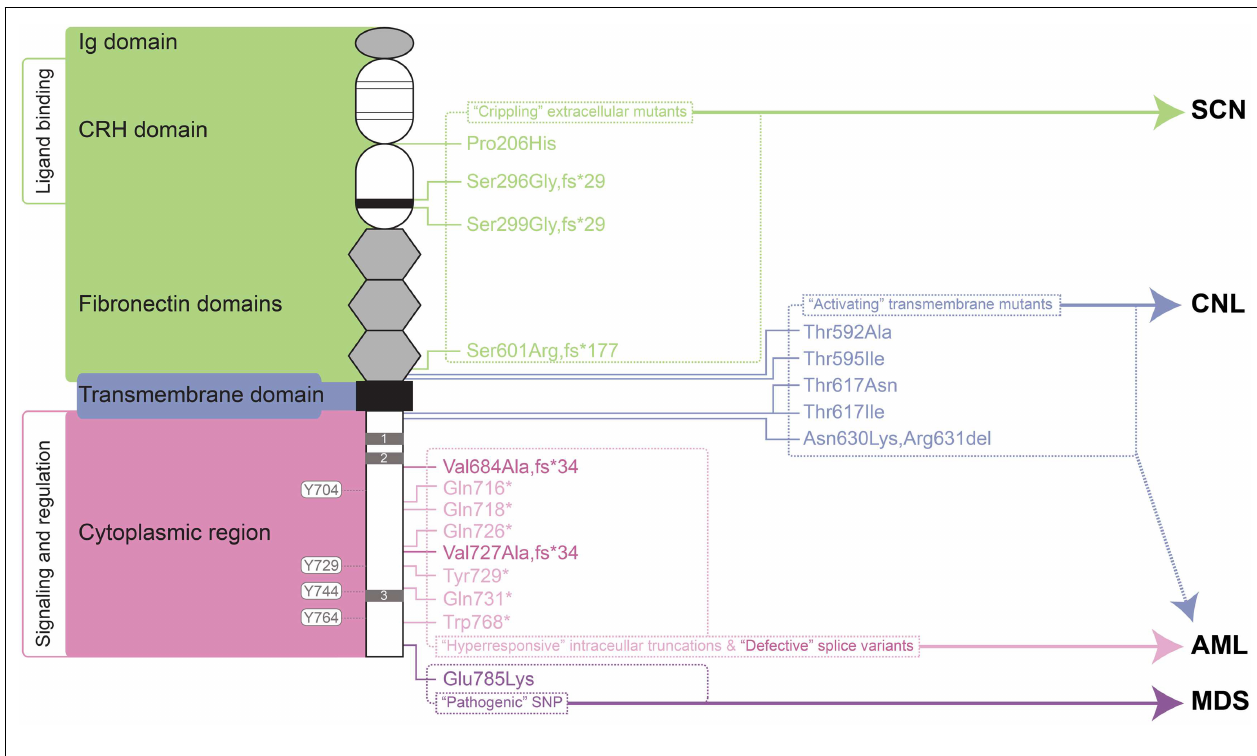
rectangles) and important tyrosine residues within the cytoplasmic region. The relative positions of various classes of mutation are indicated on the right along with the respective clinical manifestations of these and other G-CSFR perturbations. Abbreviations: Ig, immunoglobulin-like; CRH, cytokine receptor homology; SCN, severe congenital neutropenia; CNL, chronic neutrophilic leukemia; MDS, myelodysplastic syndrome; AML, acute myeloid